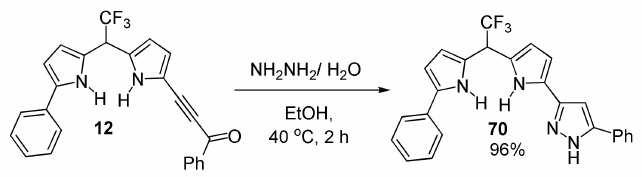
Scheme 39. Synthesis of dipyrromethane-pyrazole ensemble 70